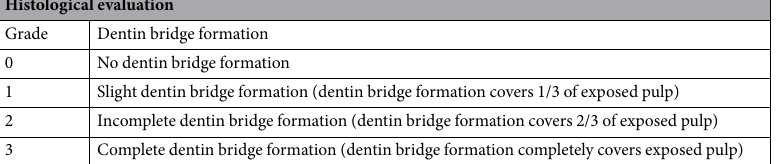
Table 1. Criteria used for histological analysis of tertiary dentinogenesis.